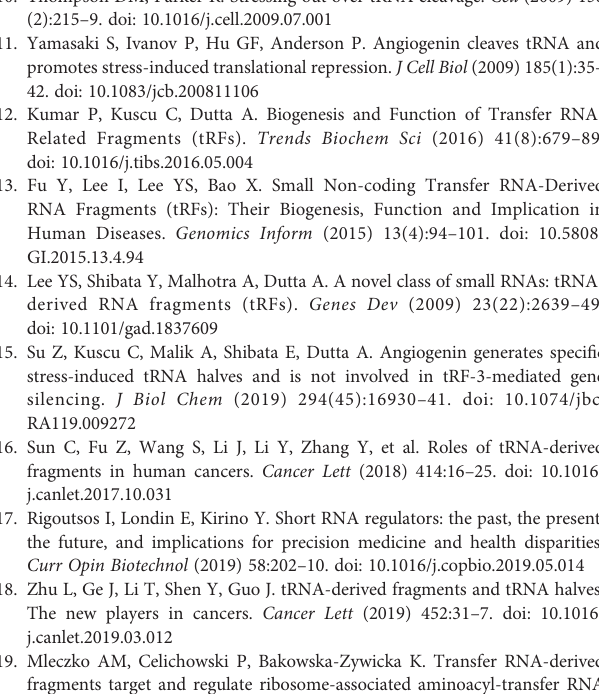
Supplementary Figure 1 | (A) Heatmap for statistically signi fi cant gene results in 10 paired GC tissues and matched NATs. (B) ROC curve of all GC patients based on tRF-3017A expression in tumor tissue samples and matched NATs. (C) ROC curve of GC patients with/without lymph node metastasis. (D) Transfection ef fi cacy was detected after transfection with tRF-3017A mimics in HGC-27 and AGS cells. (E) GC cell proliferation was detected after transfection with tRF-3017A mimics or inhibitor by CCK-8 assay. (F) NELL2 mRNA and protein levels in GC cells transfected with si-NELL2 oligo or pEX3-NELL2 plasmid. (G) 2D structure diagram based on base complementary pairing principle. Data are shown as mean ± SD. NC, negative control. *P < 0.05; **P < 0.01. (H) Analysis of NELL2 protein in 12 GC tissues and their NATs by Western blot. GAPDH protein was used as an endogenous reference. The intensity of each band was densitometrically quanti fi ed. Values under each paired tissue sample indicated the fold change of level of NELL2 proteinincancertissuesrelativetoNATs.T,tumortissue;N, NAT;T/N(tRF-3017A), the expression of tRF-3017A in cancer tissues relative to NATs. Supplementary Data Sheet 1 | Raw Data for qRT-PCR. Supplementary Data Sheet 2 | Differentially expressed genes in microarray